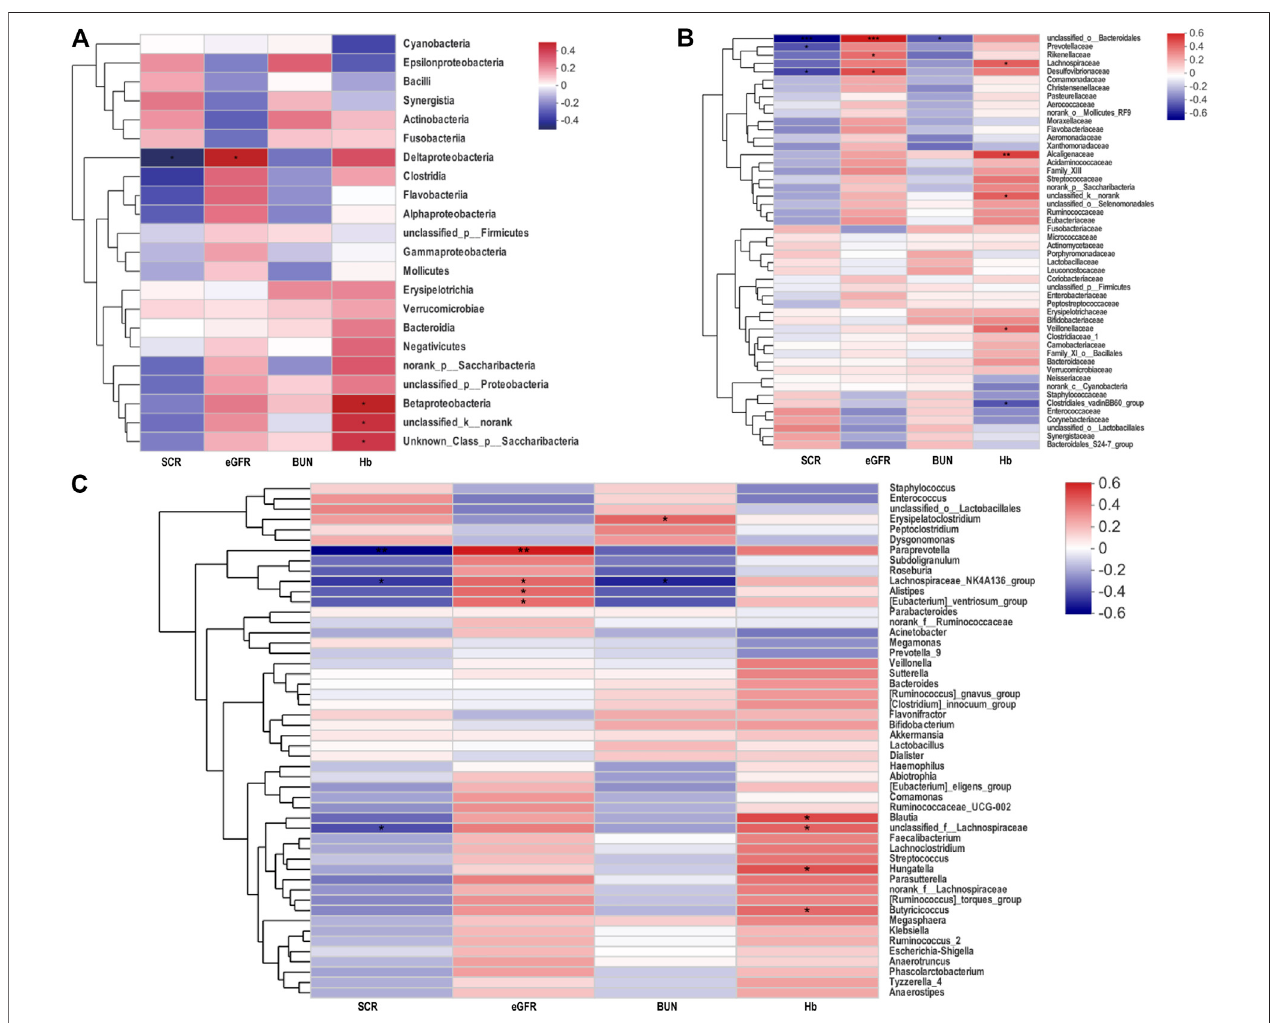
FIGURE 3 | Heatmap of Spearman ’ s correlation analysis between the gut microbiota of AAV patients and the clinical indices. (A − C) Heatmap in class, family and genus levels respectivelyshowed correlationsbetweengutmicrobiotaand biochemicalindicators.* p < 0.05; ** p < 0.01; *** p < 0.001.AAV,ANCA associated vasculitis; SCR, serum creatinine; eGFR, estimated glomerular fi ltration rate; BUN, blood urea nitrogen; Hb, hemoglobin.